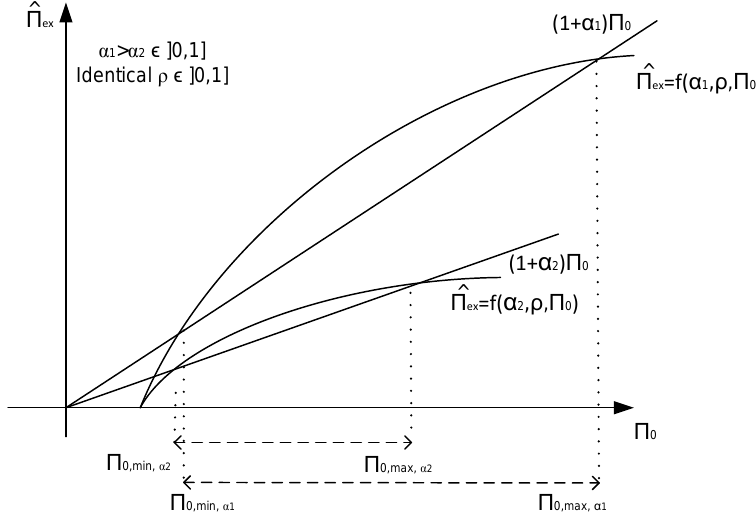
Figure 3 : Profitability zone for two different values